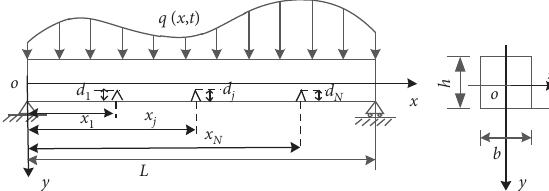
Figure 2: Geometric parameters of a viscoelastic Timoshenko cracked